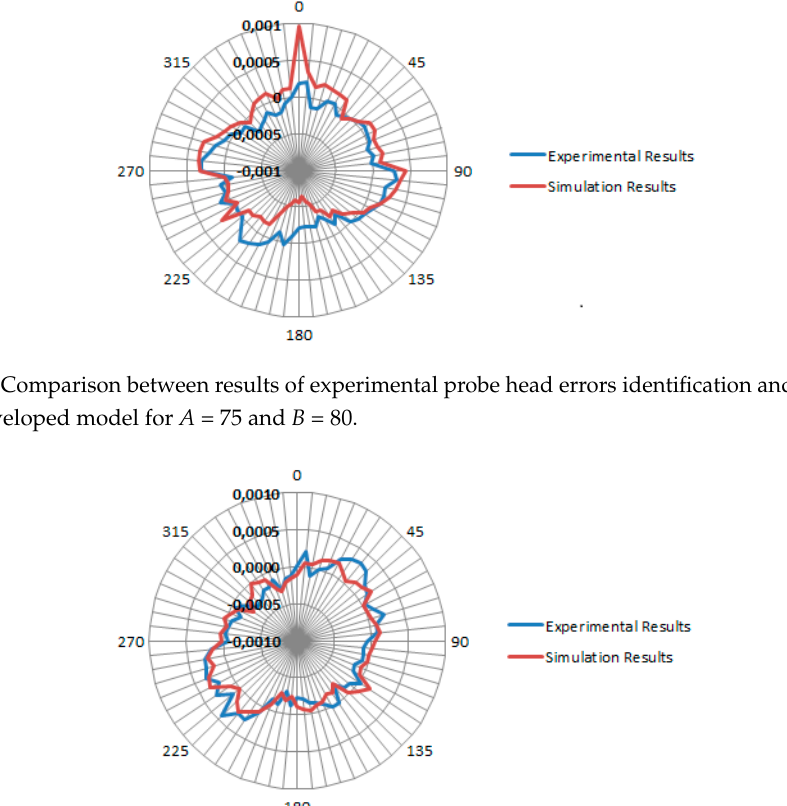
Table 2. Results of roundness deviation measurements (given in mm) for standard ring with and without probe head errors correction.